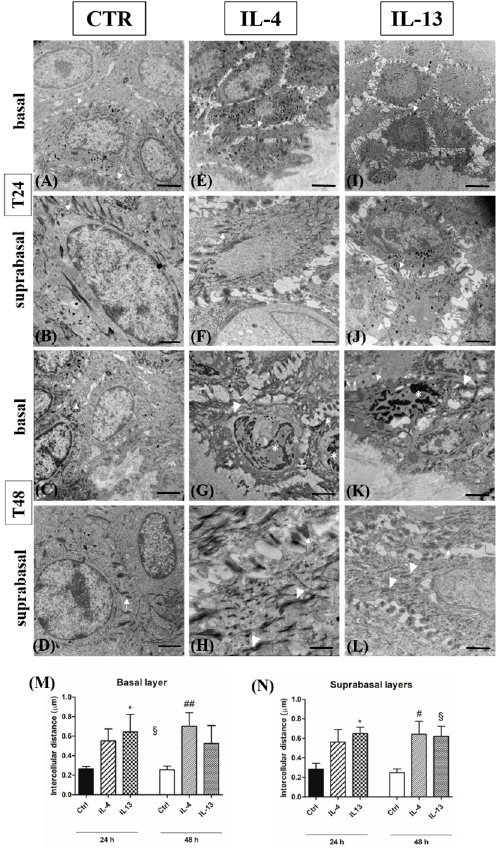
Figure 10. Transmission electron microscopy analysis. Representative photomicrographs of normal human skin araldite ultrathin sections ( A – L ) and quantitative analysis of intercellular spaces in the basal ( M ) and the suprabasal layers ( N ). ( A , B , E , F , I , J ): Samples harvested at 24 h; ( C , D , G , H , K , L ): samples harvested at 48 h. ( A , C , E , G , I , K ): Basal layer; ( B , D , F , H , J , L ): suprabasal layers. ( A – D ): CTR samples; (E-H): IL-4-treated samples; (I-L): IL-13-treated samples. Results are expressed as the mean of intercellular distance ( μ m) + 1 SD; bars indicate standard error. * p < 0,05 vs. all CTR samples; # p < 0.01 vs. all CTR samples; ## p < 0.005 vs. all CTR samples, § p < 0.001 vs. all CTR samples (Kruskal–Wallis analysis of variance followed by Dunn’s post-hoc test). CTR: control; IL-4: interleukin 4; IL-13: interleukin 13. Arrows indicate desmosomes; arrowheads indicate keratin filament aggregation; asterisks indicate chromatin condensation—scale bars ( A , C , E , G , I , K ): 2 μ m; scale bars ( B , D , F , H , J , L ): 1 μ m.